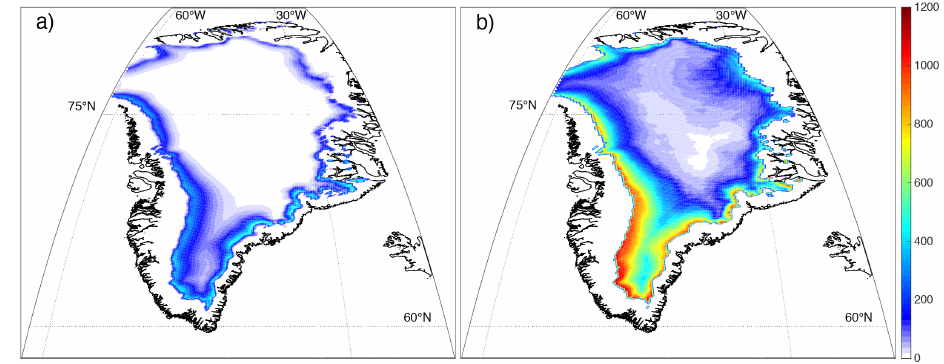
Figure 7. Regional Atmospheric Climate Model (RACMO2.3/GR) annual melt rates (kgm − 2 ) shown for areas of the GrIS with predicted positive surface mass balance (i.e. above the equilibrium line). Annual melt rates shown for (a) the 1958–1999 average and (b) for